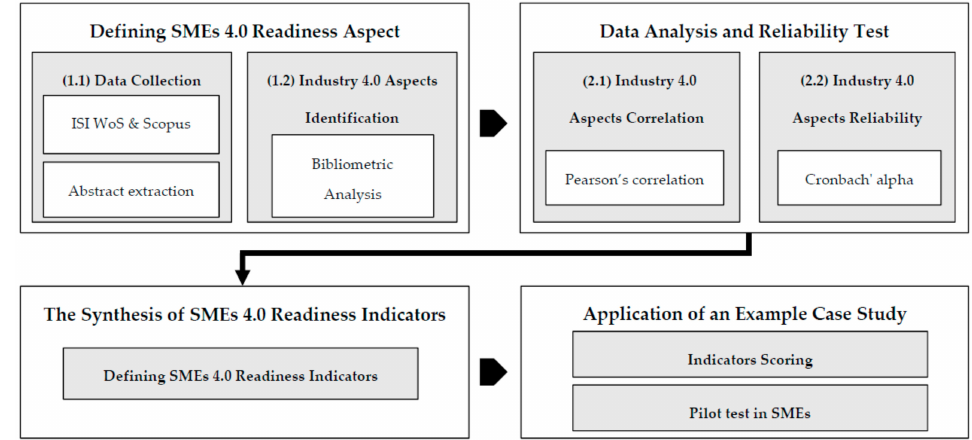
Figure 1. Research